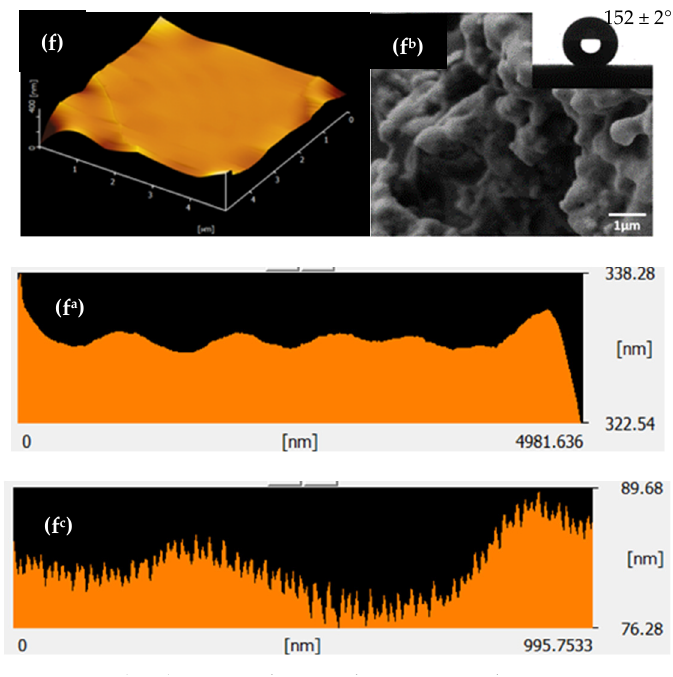
Figure 1. 3D AFM topographical images of ( a ) S1, ( b ) S2, ( c ) S3, ( d ) S1-UV, ( e ) S2-UV and ( f ) S3-UV on 5 µ m × 5 µ m area; Image of AFM line profile of ( a a ) S1, ( b a ) S2, ( c a ) S3, ( d a ) S1-UV, ( e a ) S2-UV and ( f a ) S3-UV. FESEM images and images of water droplets on ( a b ) S1, ( b b ) S2, ( c b ) S3, ( d b ) S1-UV, ( e b ) S2-UV and ( f b ) S3-UV. Image of AFM line profile of ( e c ) S2-UV and ( f c ) S3-UV on 1 µm × 1 µm area.